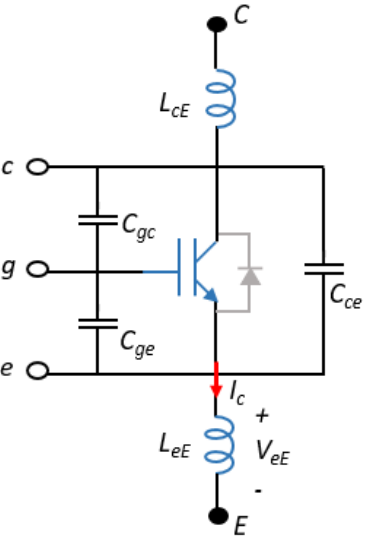
Figure 13. IGBT module equivalent circuit.